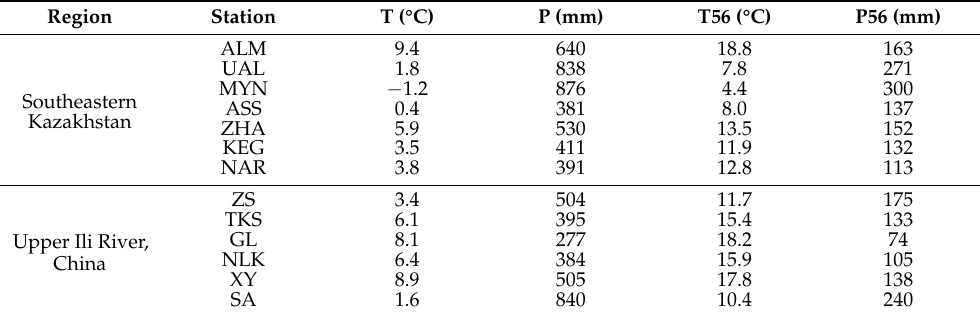
Table 3. The basic climate information of the annual and critical growing season for all meteorologi- cal